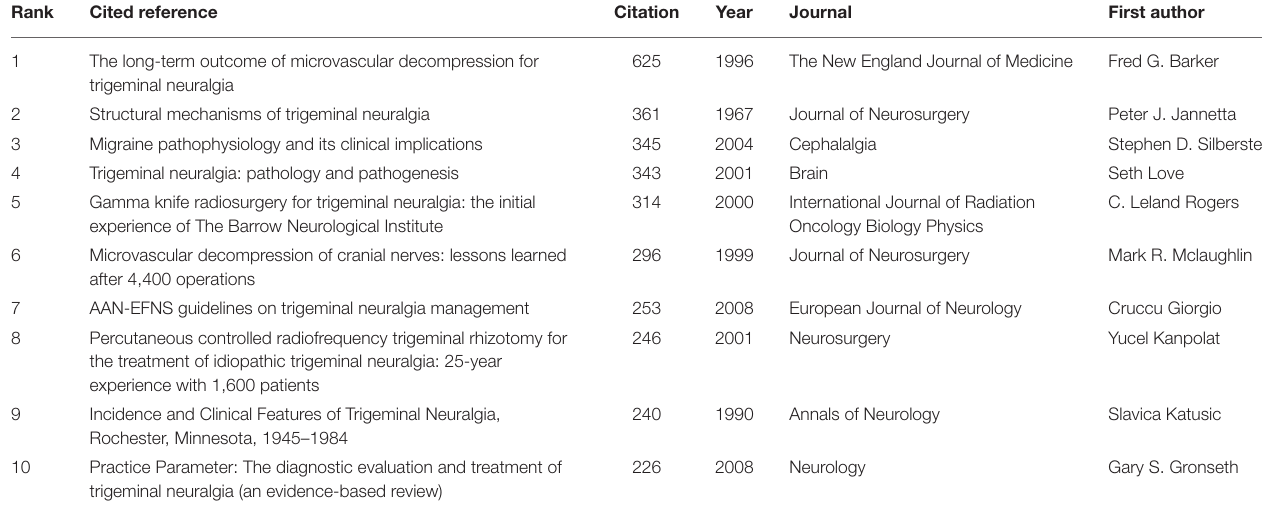
TABLE 4 | Top 10 most cited